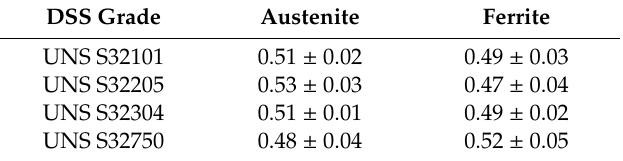
Table 2. Austenite and ferrite volume fraction of the different Duplex Stainless Steel grades.